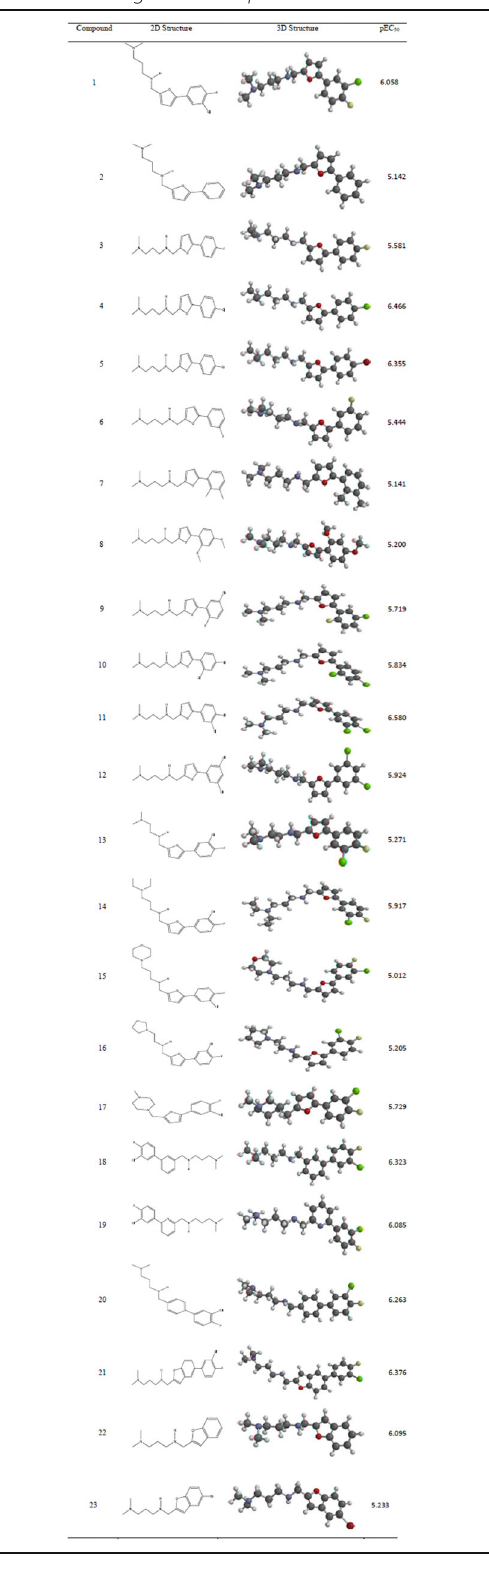
Table 1 Molecular structures of the 2,5-disubstituted furans with their activities against P . falciparum NF54